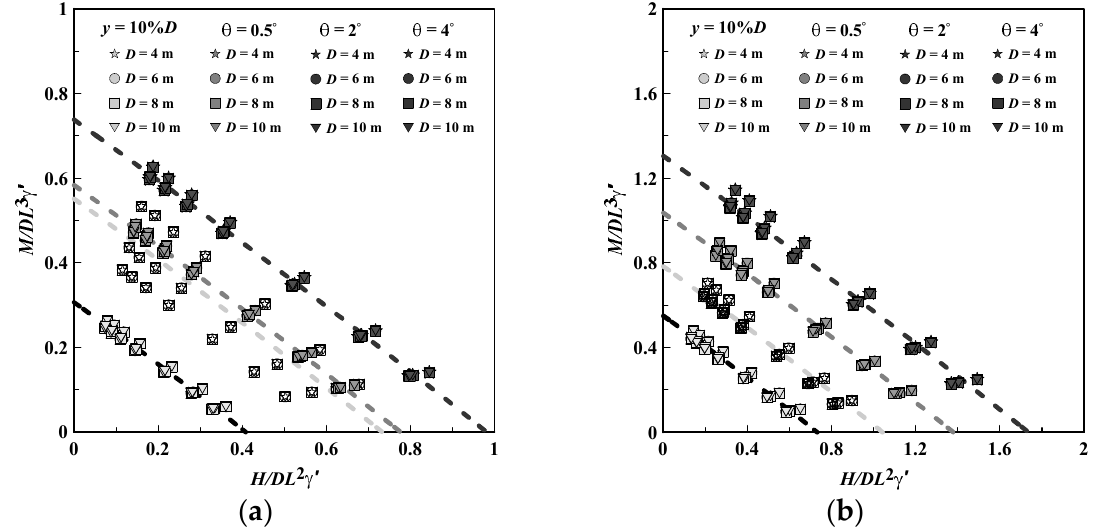
Figure 21. Normalized force–moment diagram of monopiles in 40% and 80% relative density sands under different deflection criteria: ( a ) D r = 40%, ( b ) D r = 80%. (Note: The dashed lines represent the capacity calculated based on the simplified mechanism in Figure 13 by assuming a constant K .)